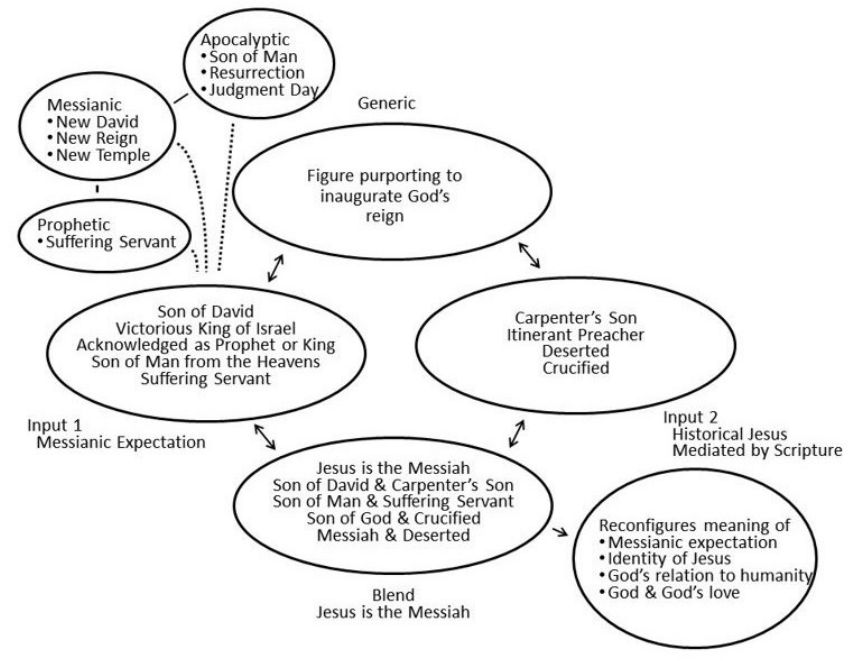
Figure 3. jesus is messiah